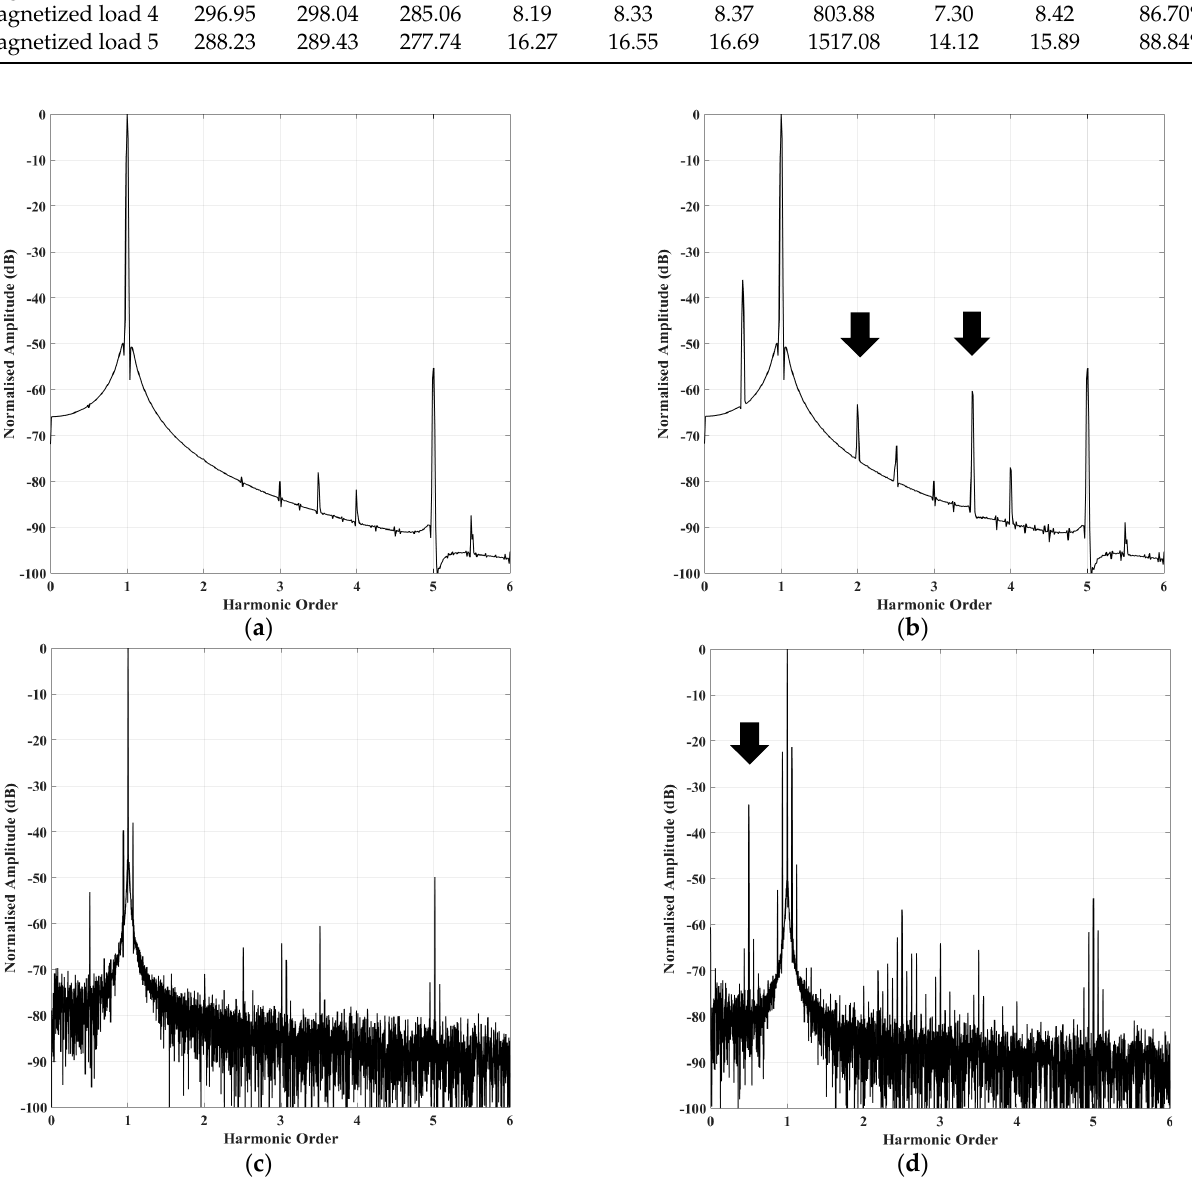
Figure 3. Simulation results. The current spectra of the generator at 100 rpm: ( a ) Simulation healthy; ( b ) Simulation local demagnetization; ( c ) Experiment healthy; ( d ) Experiment local demagnetiza- tion.